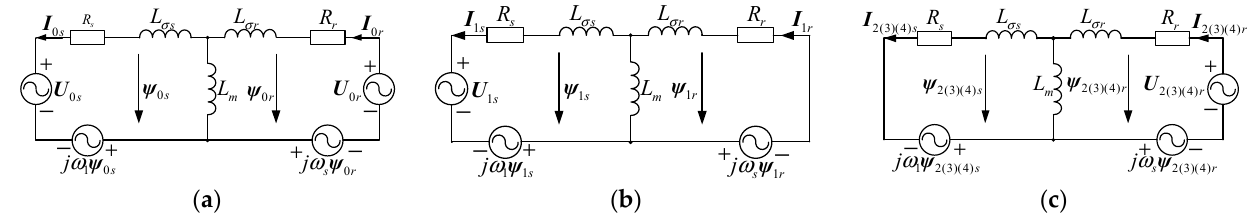
Figure 5. Equivalent T circuit diagram of DFIG in different states. ( a ) State 0; ( b ) State 1; ( c ) State 2, State 3, and State 4.